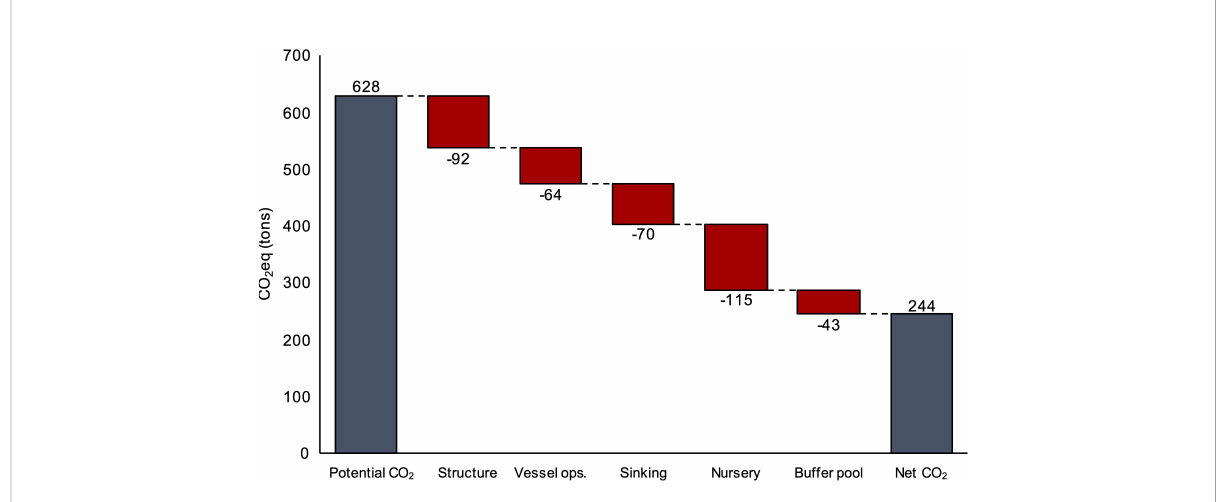
FIGURE 5 Deductions from the annual quantity of CO 2 eq sequestered each year within kelp biomass ( “ Potential CO 2 ” ) as a result of annual emissions from farm components ( “ Structure ” ), contracted vessel fuel consumption ( “ Vessel ops. ” ), biomass transport and sinking ( “ Sinking ” ), “ Nursery equipment and energy ( “ Nursery ” ), and the 15% “ Buffer pool ” . The emissions represented by “ Vessel ops. ” do not include the fuel required to transport harvested biomass to the sink site. The category “ Sinking ” accounts for biomass transport emissions.